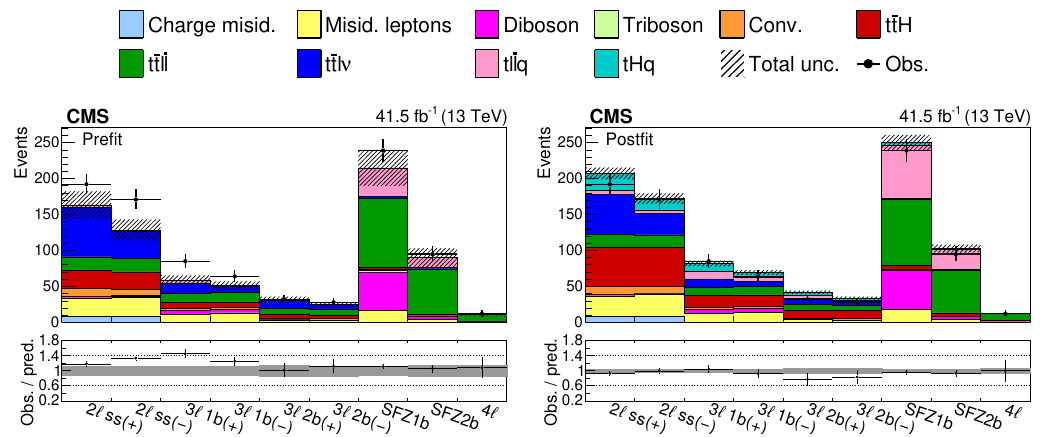
Figure 3 . Expected yields prefit (left) and postfit (right). The postfit values of the WCs are obtained from performing the fit over all WCs simultaneously. “Conv.” refers to the photon conver- sion background, “Charge misid.” is the lepton charge mismeasurement background, and “Misid. leptons” is the background from misidentified leptons. The jet multiplicity bins have been combined here, however, the fit is performed using all 35 event categories outlined in section 5.4. The lower panel is the ratio of the observation over the